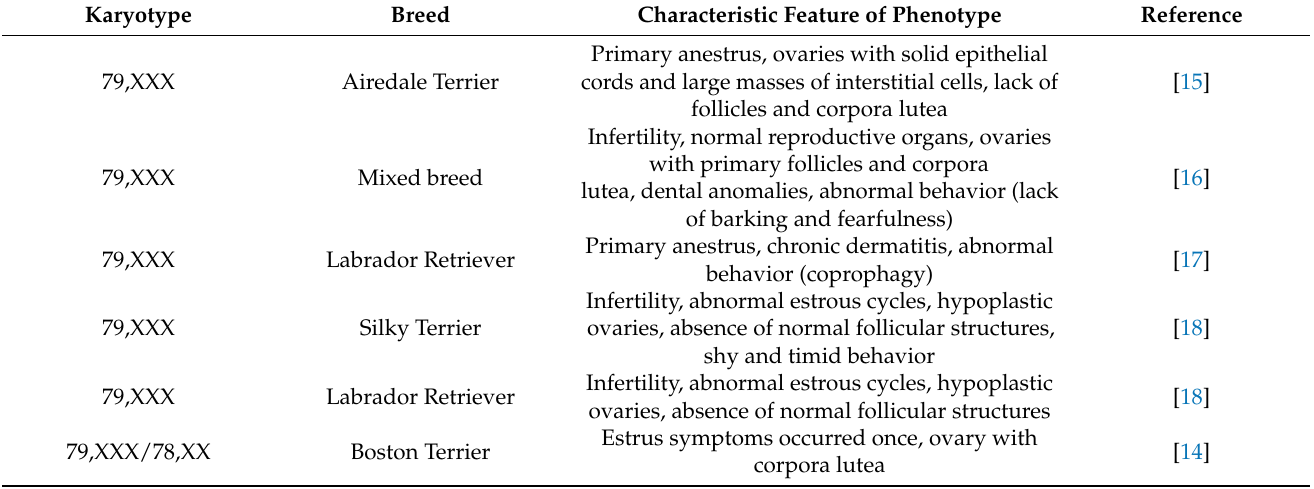
Table 2. Cases of X trisomy reported in